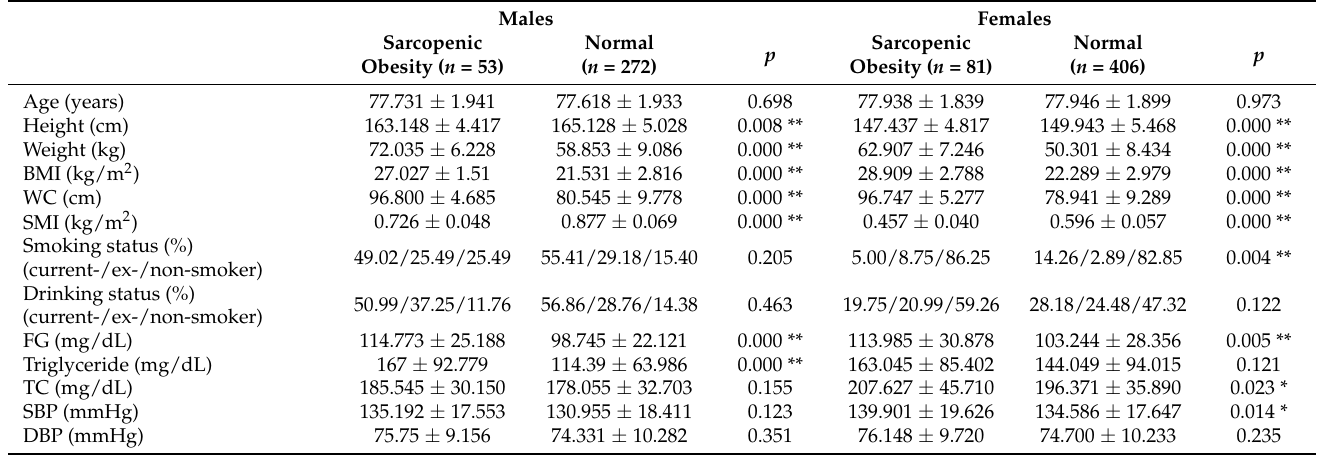
Table 3. Sex-specific clinical parameters associated with sarcopenic obesity